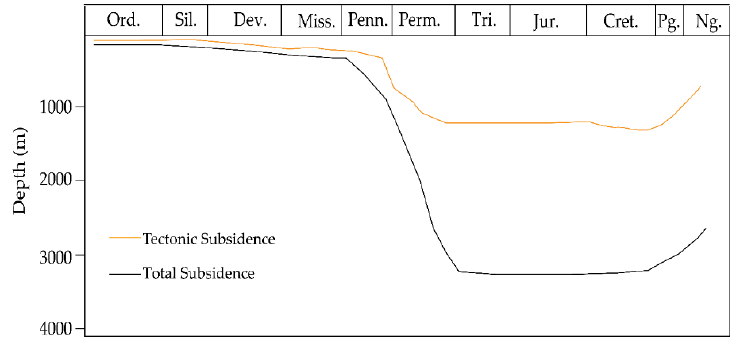
Figure 3. Subsidence curve for the eastern part of the Midland Basin after Yang and Dorobek, 1995 [54], Ewing, 1993 [67], and Heij and Elmore, 2020 [71].